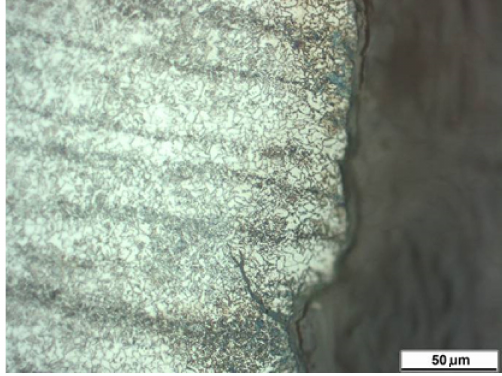
Figure 13. Development of secondary